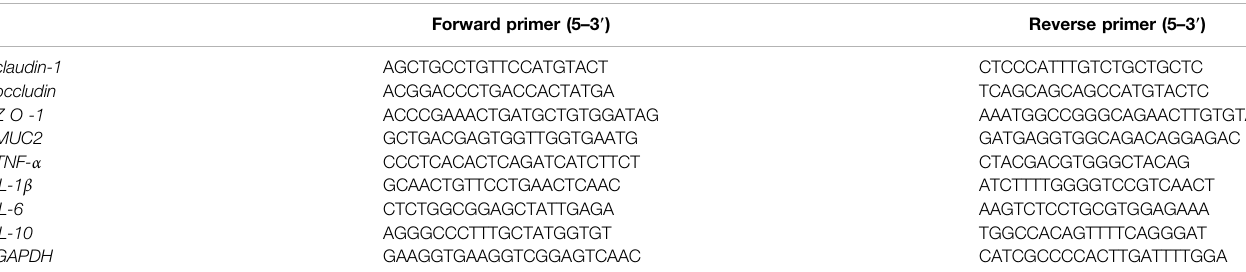
TABLE 2 | Primers used for